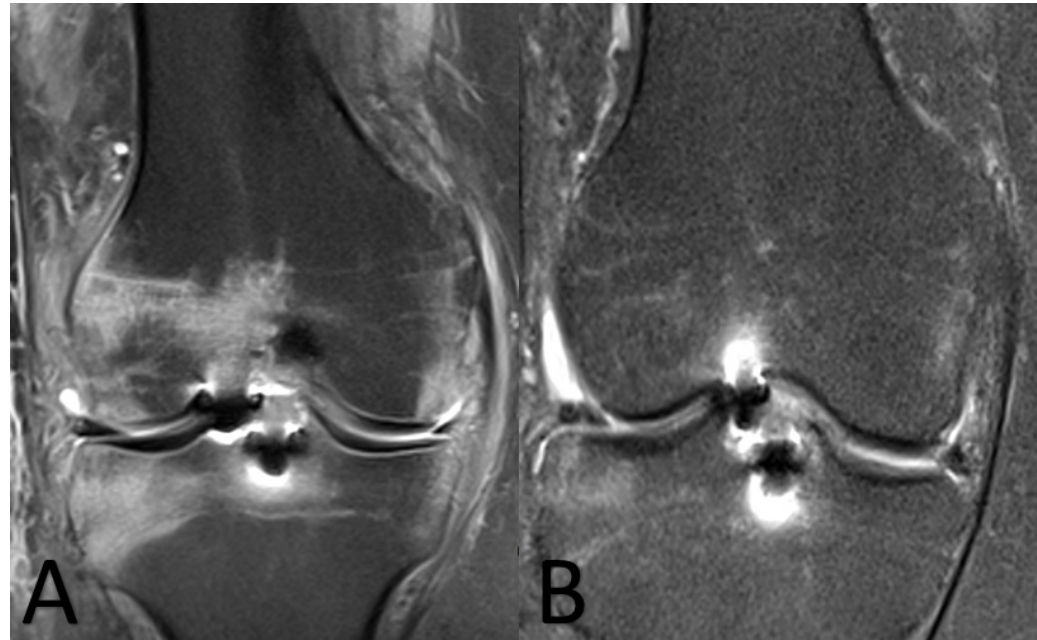
Figure 1. Coronal MRI views of the knee. ( A ) Fourteen days after the initial anterior cruciate ligament reconstruction; diffusely increased T2 signal/bone marrow edema is noted surrounding the ligament anchors, extending to the lateral femoral condyle, lateral tibial plateau, intercondylar eminences and the intercondylar notch. ( B ) Six months after antifungal treatment; imaging findings have notably subsided, indicating response to treatment.